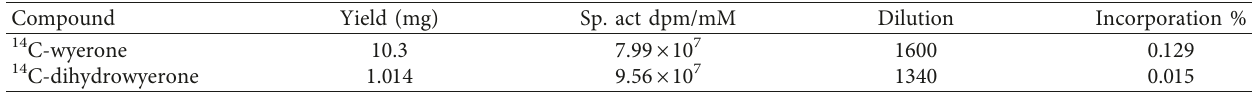
Table 2: Mean radioactivity measurement of separated 14 C-wyerone and 14 C-dihydrowyerone from first feeding experiment obtained after separation by HPLC. The results are average of two trials.